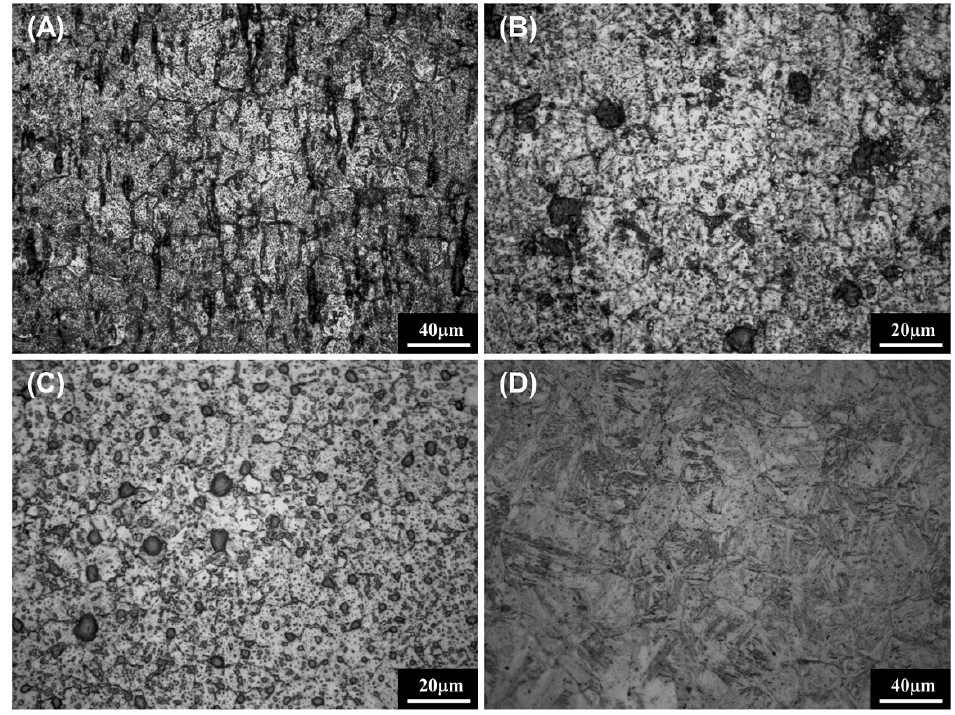
Figure 10. Microstructures of ( A ) EM, ( B ) AM, ( C ) DM and ( D ) OM observed by optical microscopy. Scale bar is 40 μ m ( A , D ) and 20 μ m ( B , C ).